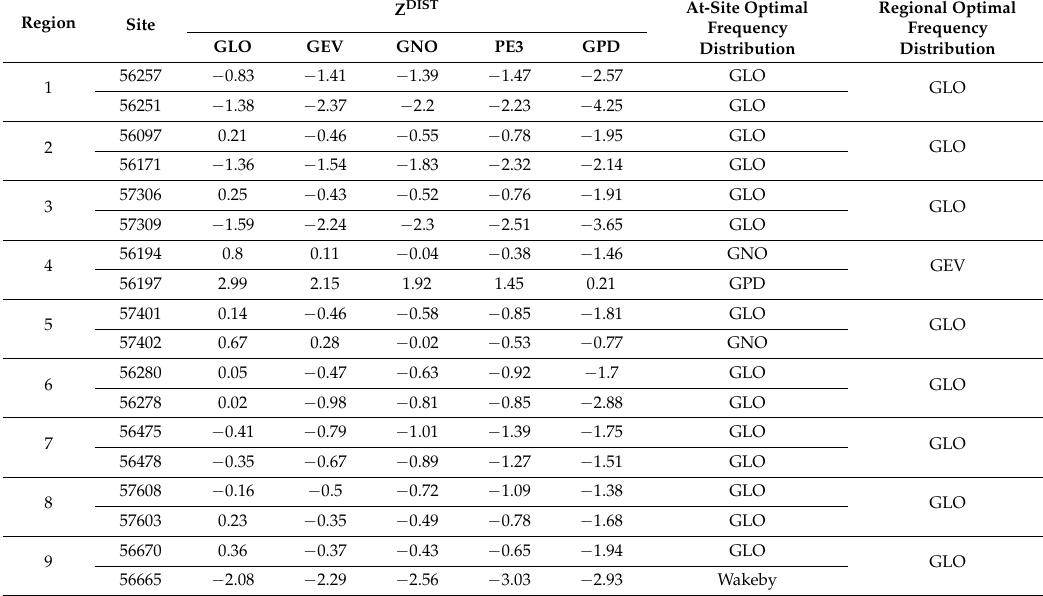
Table 3. Monte Carlo simulation test results for each representative site and the optimal frequency distribution for each homogeneous